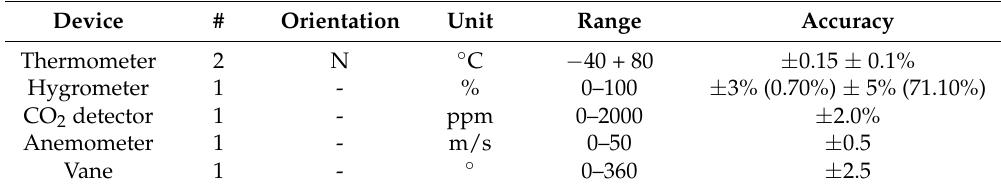
Table 2. Probes in the weather